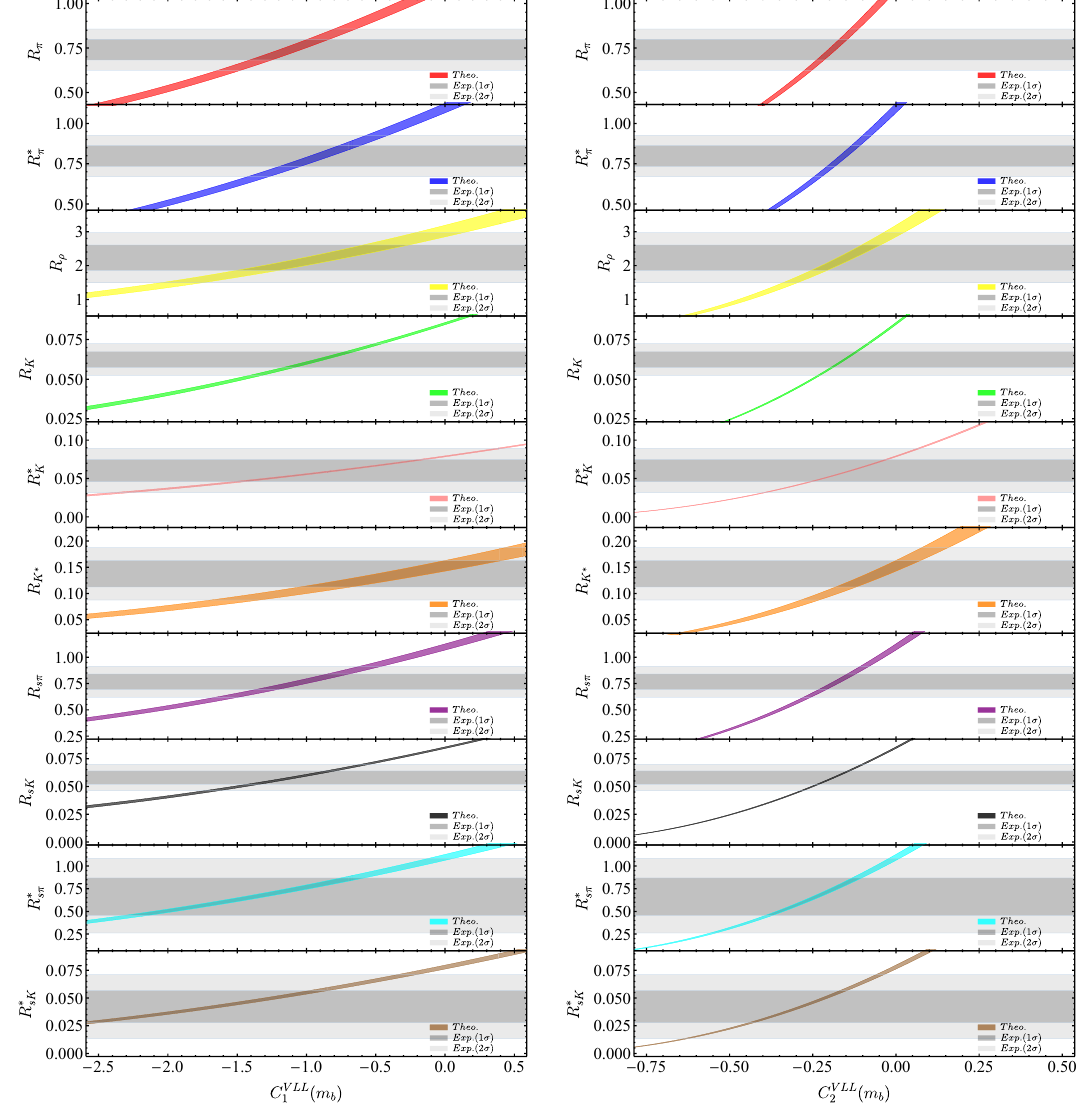
Figure 5 . Constraints on the NP Wilson coefficients C V LL ( m b ) (left) and C V LL ( m b ) (right) from 1 2 the ratios R π (red), R ∗ (blue), R ρ (yellow), R K (green), R ∗ (pink), R K ∗ (orange), R sπ (purple), π K R sK (black), R ∗ (cyan), as well as R ∗ (brown), respectively. The horizontal bounds represent sπ sK the experimental ranges within 1 σ (dark gray) and 2 σ (light gray) error